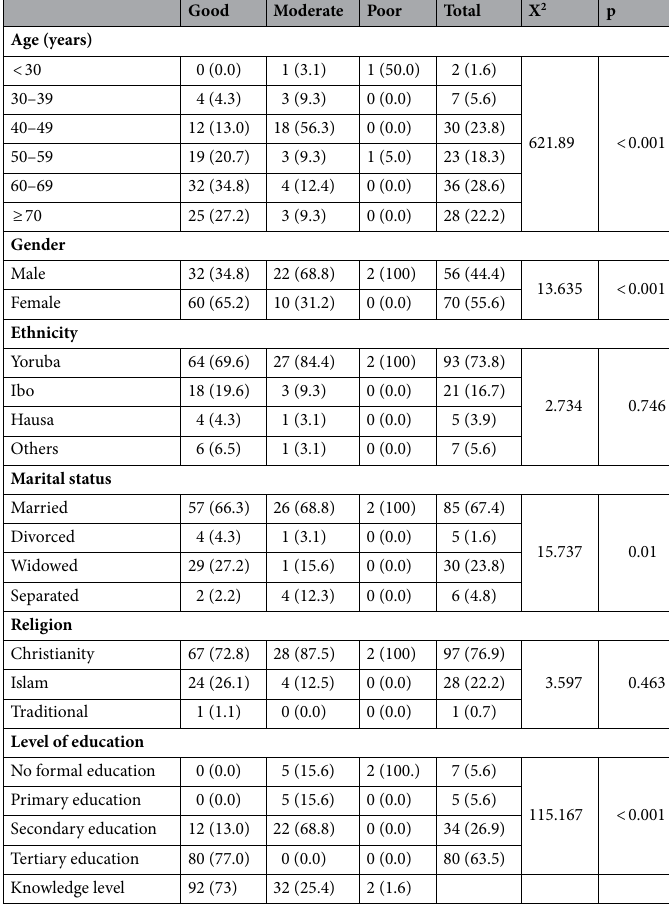
Table 3. Relationship between socio-demographic characteristics and knowledge of diabetes mellitus. Values in parenthesis indicate % while X 2 and p represent chi-square and probability values,